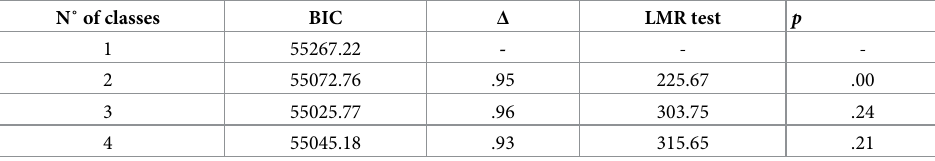
Table 3. Fit indices for the mixture analyses based on the 4-factor CAA model.